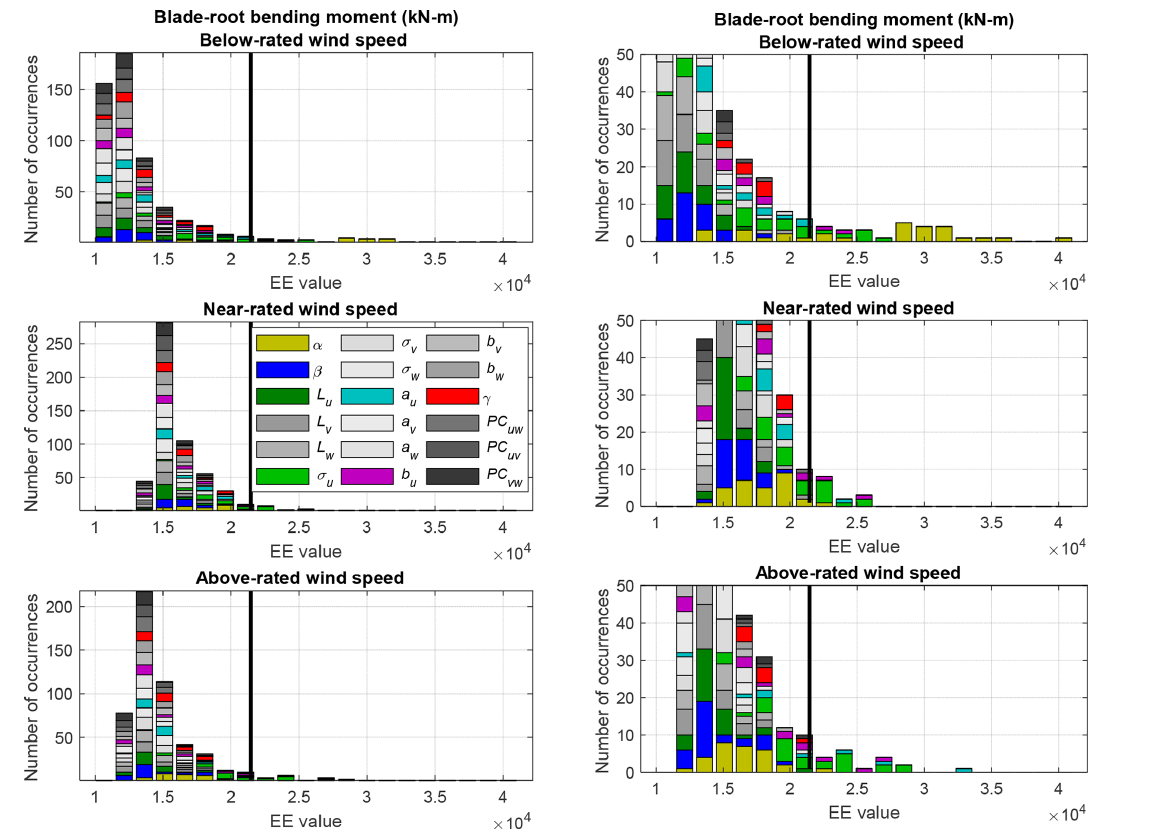
Figure 7. Histograms of ultimate load EE values for the blade-root bending moment. Each graph in the left column shows one wind speed bin and includes all input parameters. Right column is a zoomed-in view of the